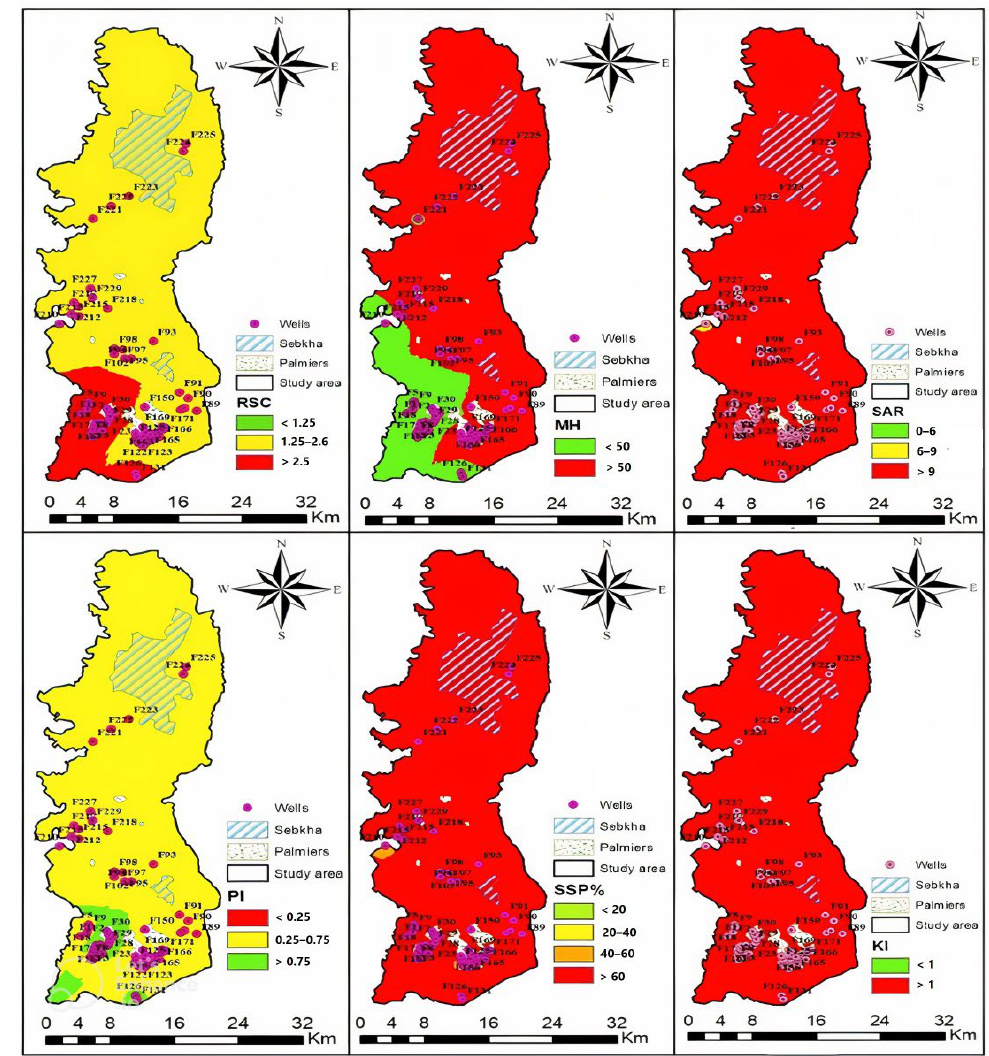
Figure 8. Geo-spatial distribution of suitability for irrigation indices.